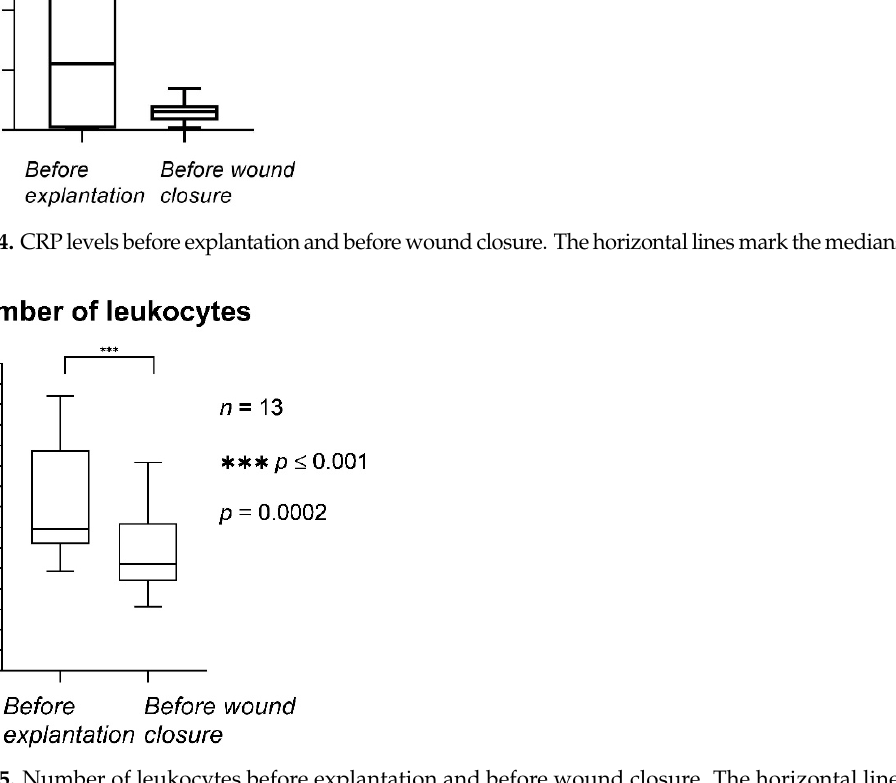
Figure 5. Number of leukocytes before explantation and before wound closure. The horizontal lines mark the medians.